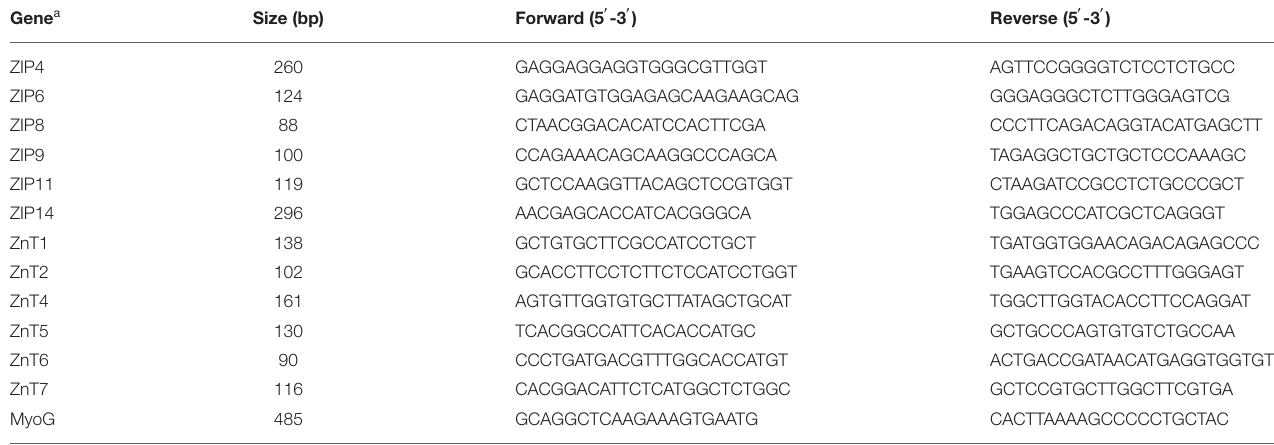
TABLE 1 | Real-time PCR primer sequence. Gene